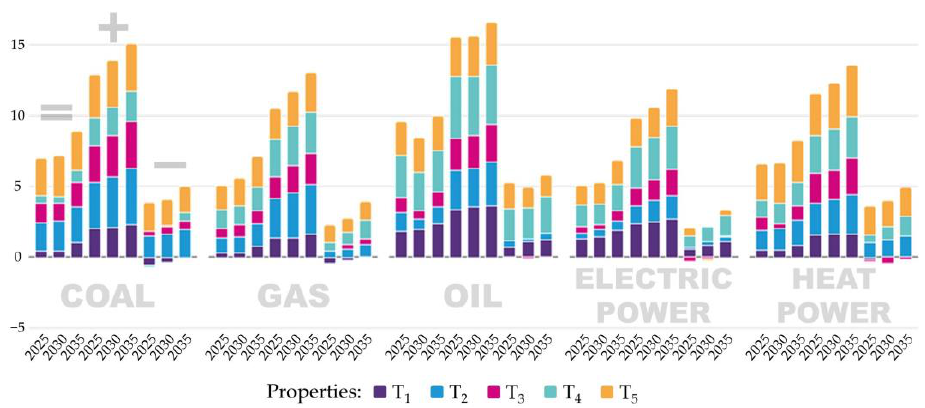
Figure 11. Industry’s scenario coefficients of the development of properties of the Eastern LFEC at three time intervals.